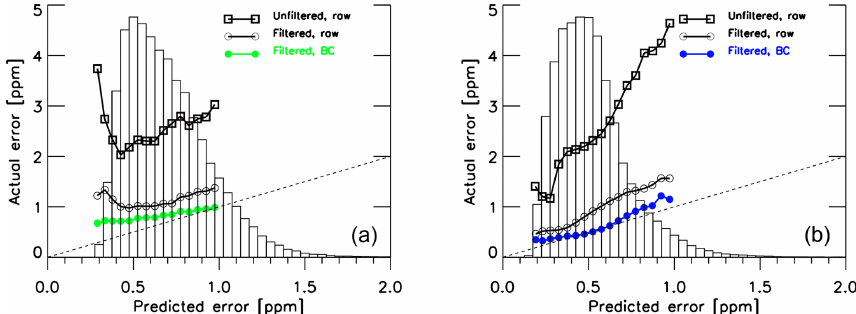
Figure 19. Binned median values of the actual versus predicted RMS XCO 2 error for the full annual dataset for nadir–land (a) and glint– water soundings (b) . Each panel shows the unfiltered raw XCO 2 (open diamonds), the raw XCO 2 for the soundings assigned a good QF (open circles), and the and bias-corrected XCO 2 for the soundings assigned a good QF (closed circles). To provide reference, the raw, unfiltered dataset is also displayed as a histogram. The one-to-one line is given as a dashed